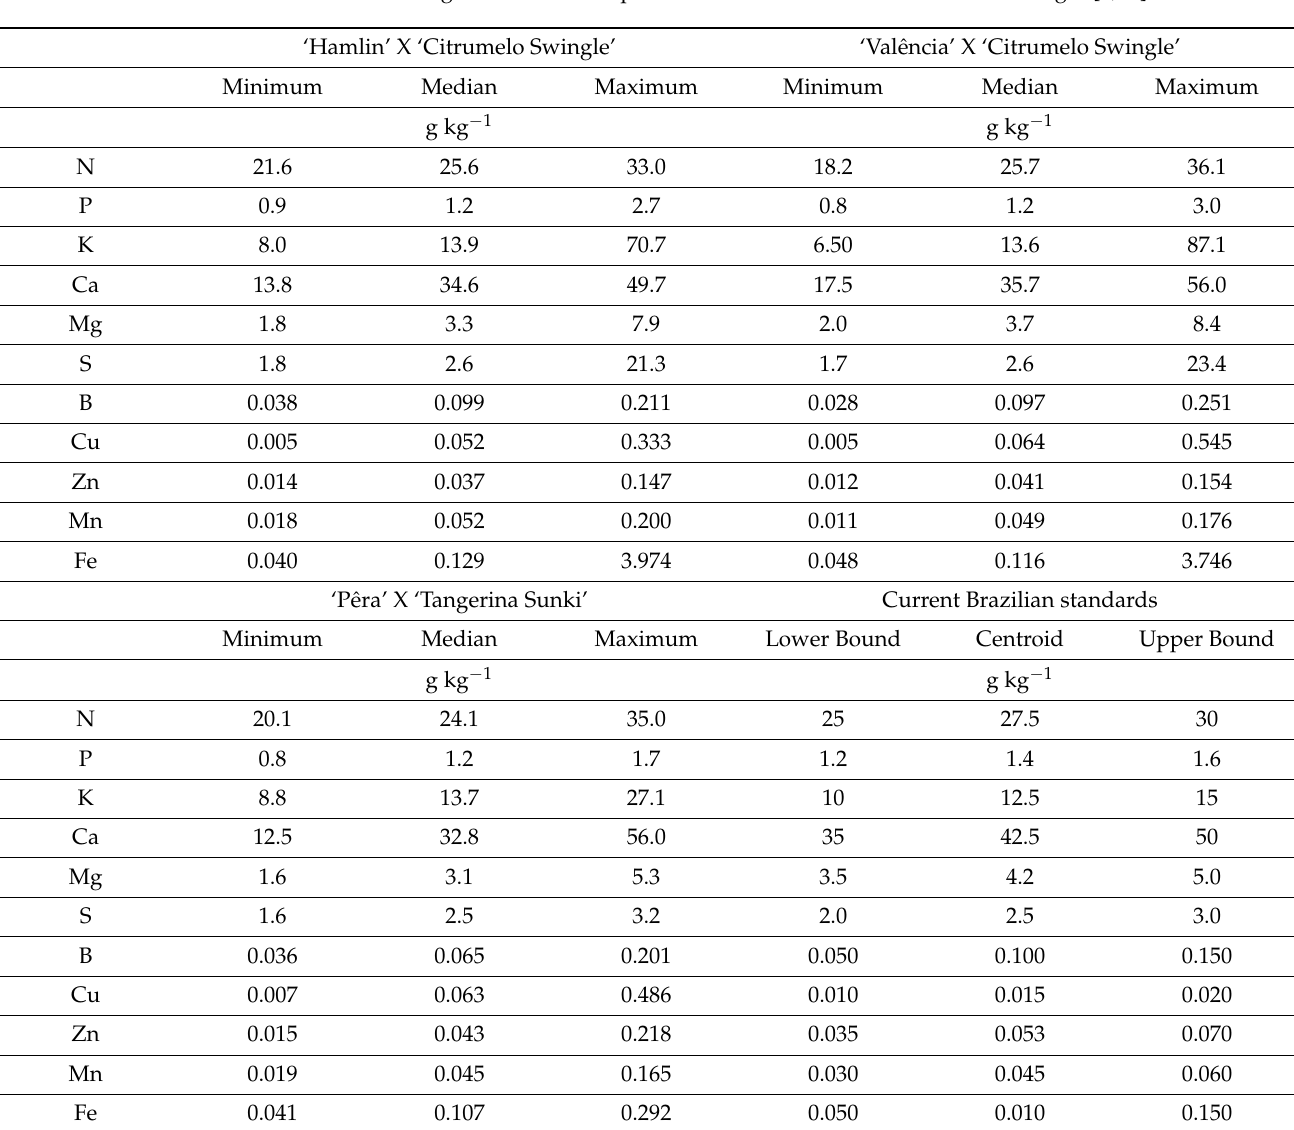
Table 2. Tissue test results for ‘Hamlin’ X ‘Citrumelo Swingle’, ‘Val ê ncia’ X ‘Citrumelo Swingle’, and ‘P ê ra’ X ‘Tangerina Sunki’ compared to current Brazilian concentration ranges [3,77]. ‘Hamlin’ X ‘Citrumelo